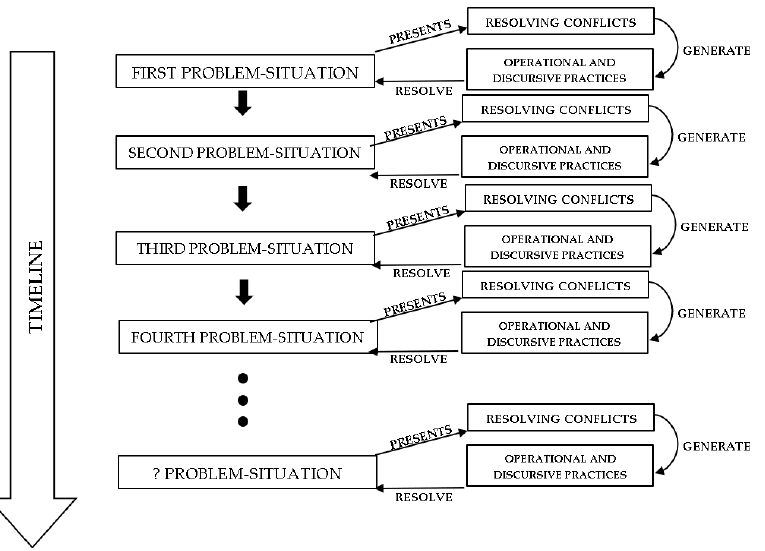
Figure 1. Proposed development of the binomial distribution. Considering the HES of probability [4], we propose that the development of the study of binomial phenomena occurs in a progressive manner and as a result of resolving conflicts in new problem situations.